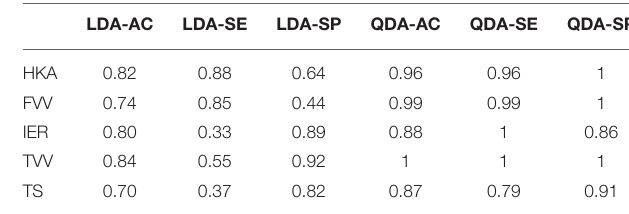
TABLE 3 | Classification test, exploiting LOO cross-validation, of linear vs. quadratic discriminant analysis using all SSM parameters.